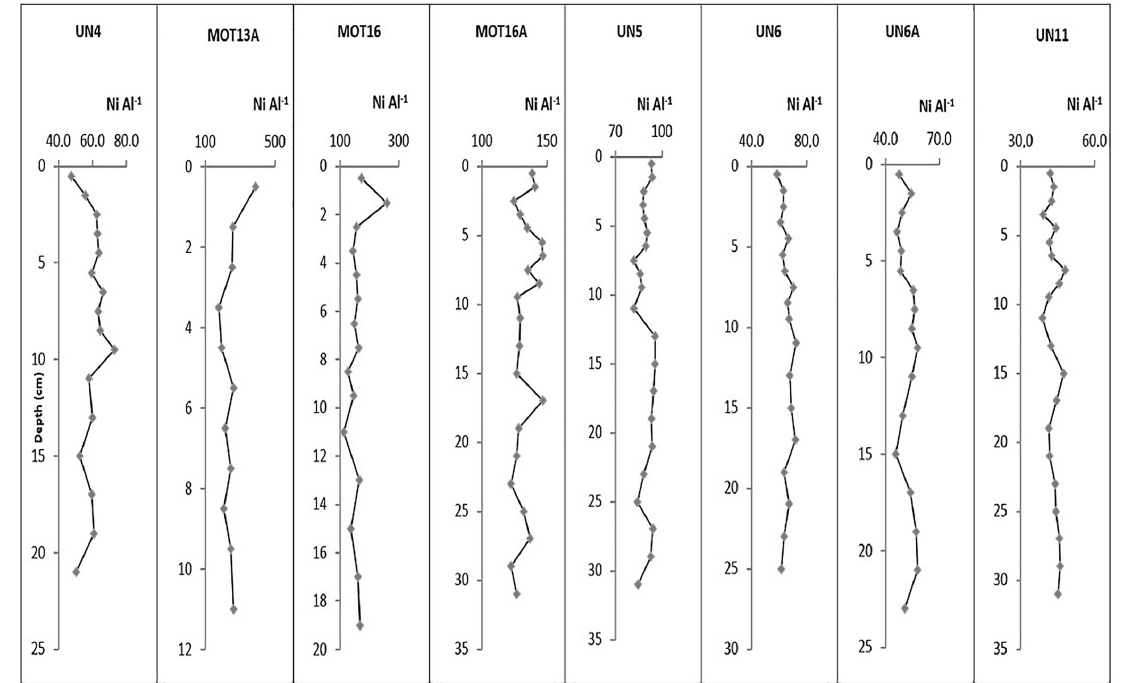
Figure A5. Vertical distributions of Ni Al − 1 × ( 10 4 ) in sediment cores. The ratios in the coarse cores MOT13A, MOT16 and UN4 are calculated at the fine-sediment fraction ( < 63µm).